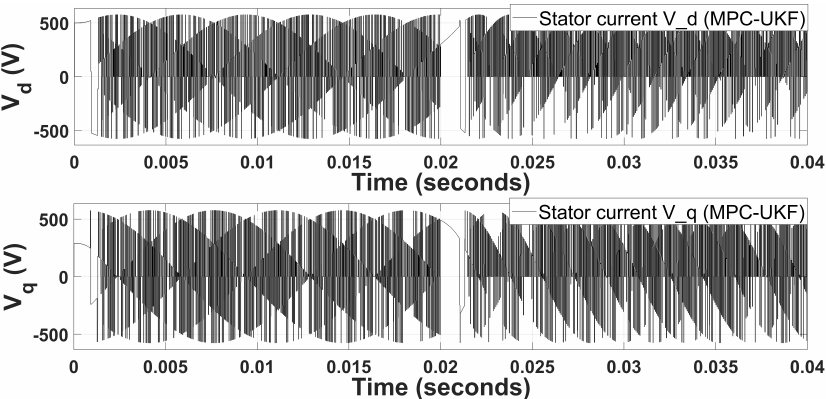
Figure 7. dq -reference stator voltages for MPC-UKF.